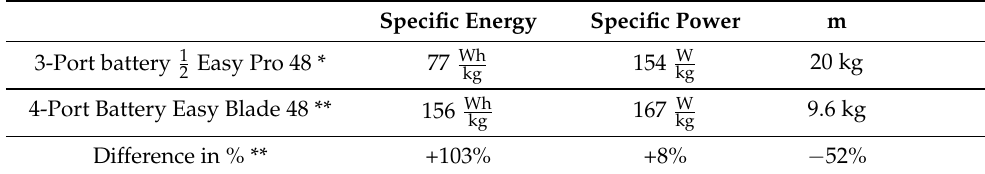
Table 6. Comparison of the batteries for the different topologies. Specific Energy